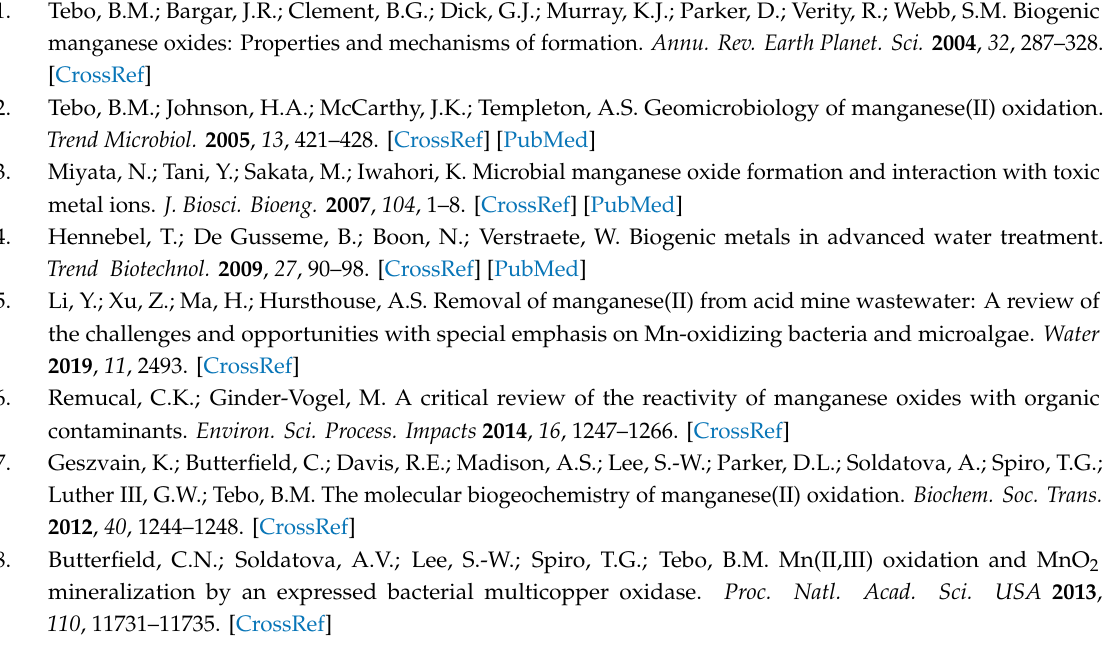
Figure S1: Nucleotide and deduced amino acid sequences of mco1 gene from A. strictum KR21-2, Figure S2: Neighbor-joining phylogenetic tree showing the relationship of A. strictum KR21-2 Mco1 with related MCOs, Figure S3: Homology model of A. strictum KR21-2 Mco1 and crystal structure of bilirubin oxidase from Albifimbria verrucaria (AvBOx), Figure S4: SEM images of solid-phase Mn produced by the enzyme reaction, Table S1: Primers used in this